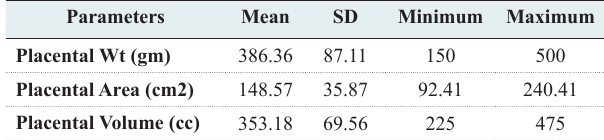
Table 1: Placental Morphometric Study